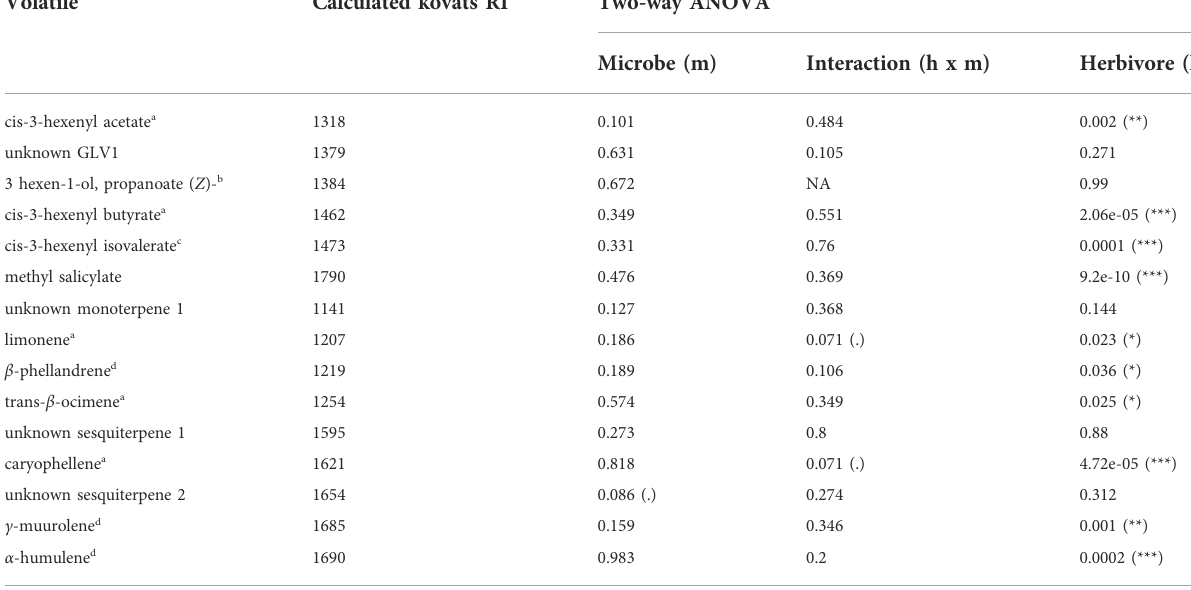
TABLE 1 Volatiles emitted by tomato plants according to their measured retention time and calculated Kovats retention index